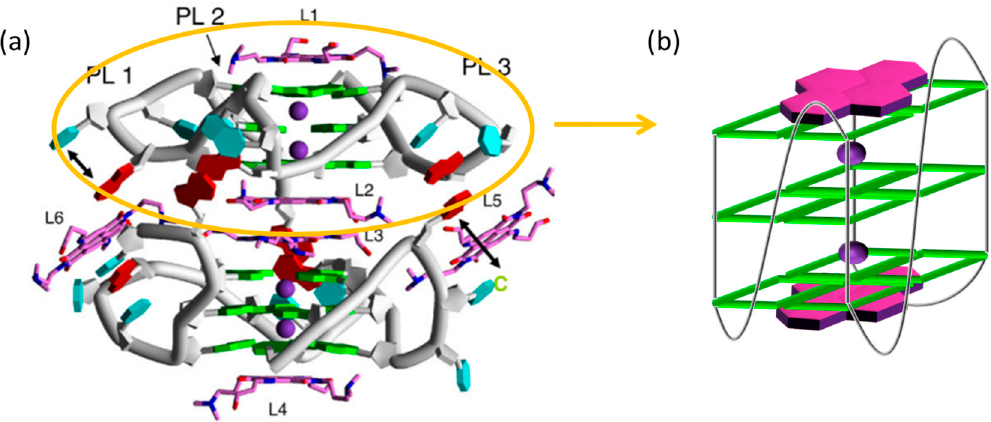
Figure 2. ( a ) The crystal structure of the 23-mer intramolecular G4 d[TAGGG(TTAGGG) 3 ] complexed with tetra-substituted naphthalene diimide ligands (Figure taken from [25]); ( b ) model of the NDI-G4 binding through π -stacking interactions.